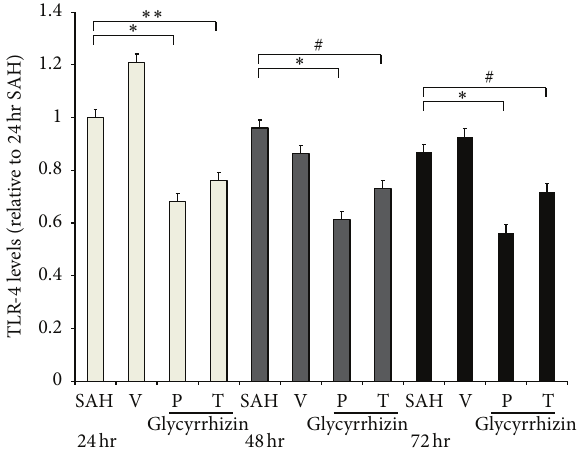
Figure 2: Effect of glycyrrhizin on proinflammatory cytokines in the CSF. IL-1 𝛽 , IL-6, and MCP-1 were measured by rt-PCR. Samples were collected at 72 hr after the induction of SAH, when the vasoconstriction was robust. All values are mean ± SD ( 𝑛 = 9 ). ∗ , ∗∗ , ∗∗∗ : 𝑃 < 0.01 , and # , ## : 𝑃 > 0.05 when compared with the SAH group.